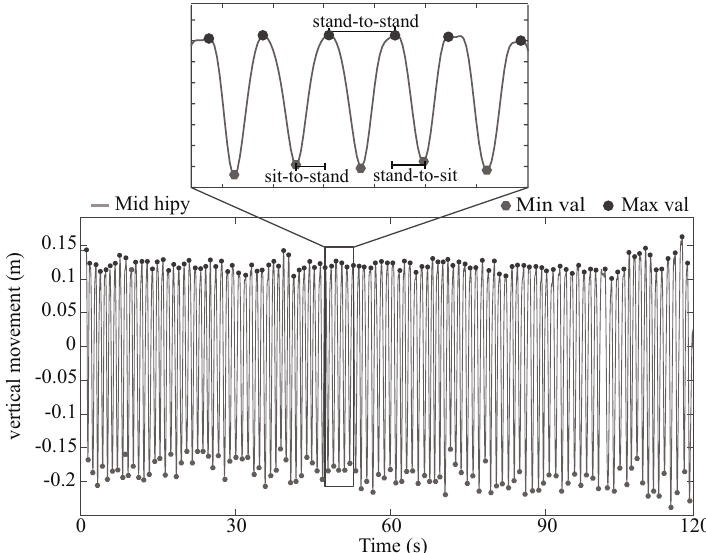
Figure 4. M_hip vertical movement signal, maximum, minimum and phase